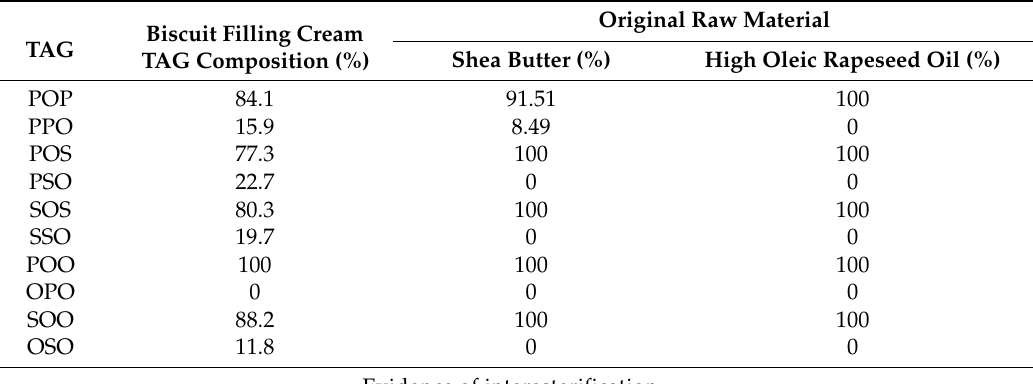
Table 2. Comparison of TAG (triglyceride) percent composition between original raw materials and confectionery final products (biscuit filling cream).